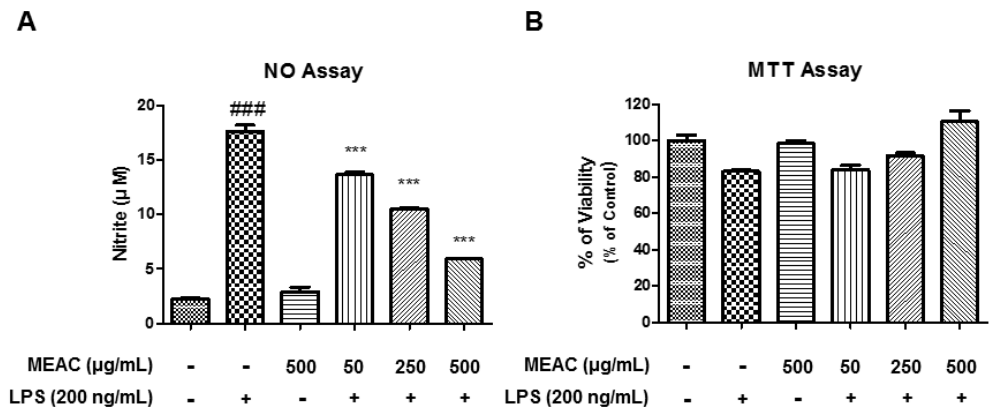
Figure 1. E ff ect of methanol extract of A. cepa (MEAC) on nitric oxide (NO) production and cell viability in lipopolysaccharide (LPS)-induced BV-2 microglial cells. ( A ) The treatment with MEAC on the suppression of LPS-stimulated NO release in BV-2 microglial cells. ( B ) MEAC treatment-mediated cell viability was evaluated using the 3-(4,5-dimethylthiazol-2-yl)-2,5-diphenyltetrazolium bromide (MTT) assay. The results present as a percentage of the control samples. Data are presented as the mean ± SEM. ### p